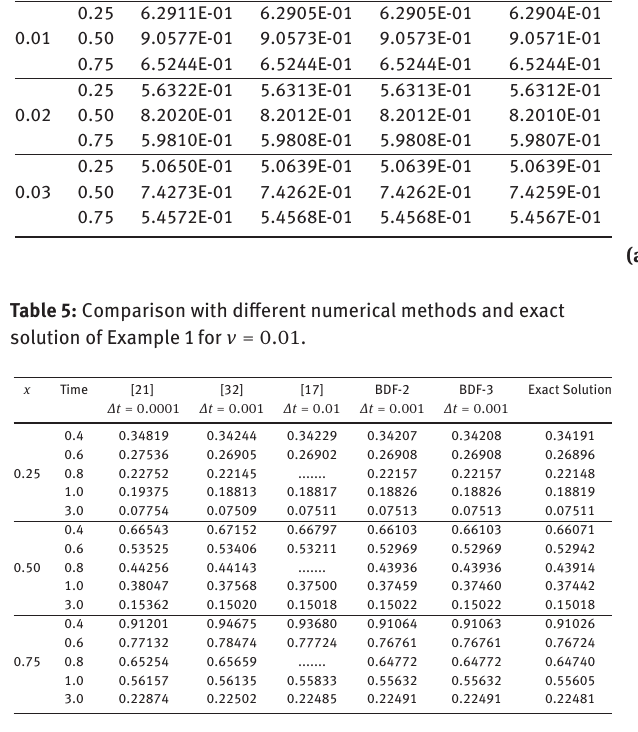
Table 6: Comparison of Errors in L 2 norm and L ∞ norm with Δt = 0.0001 for different values of ν , corresponding to Example 1.